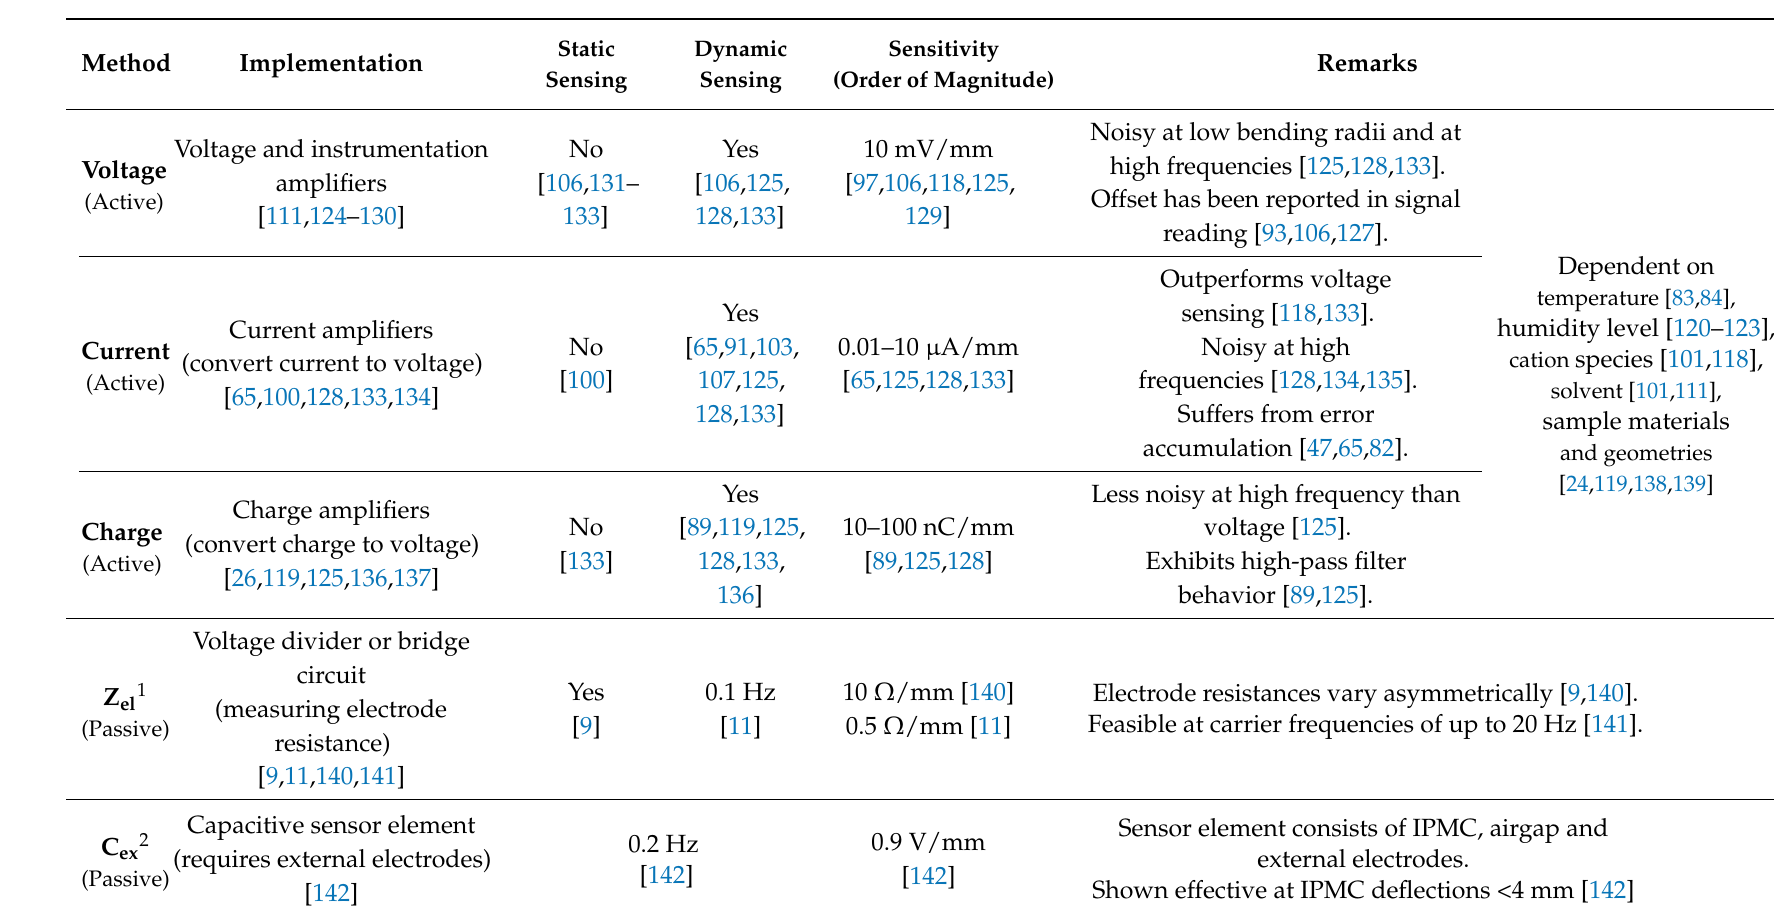
Table 1. Reported methods for sensing deformation of